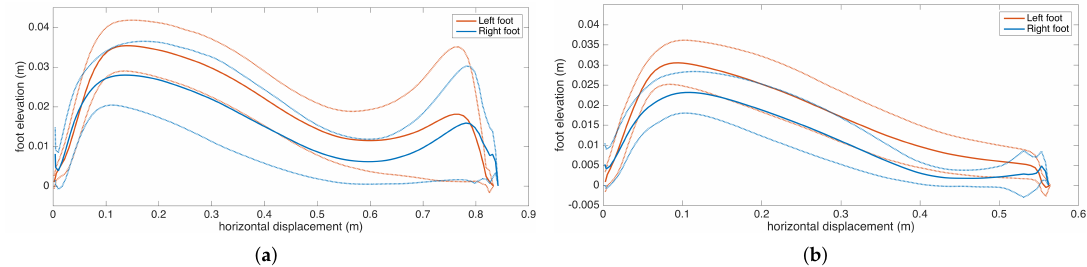
Figure 18. Lateral step profile of a PD patient (Subject 17). ( a ) ON state and ( b ) OFF state.